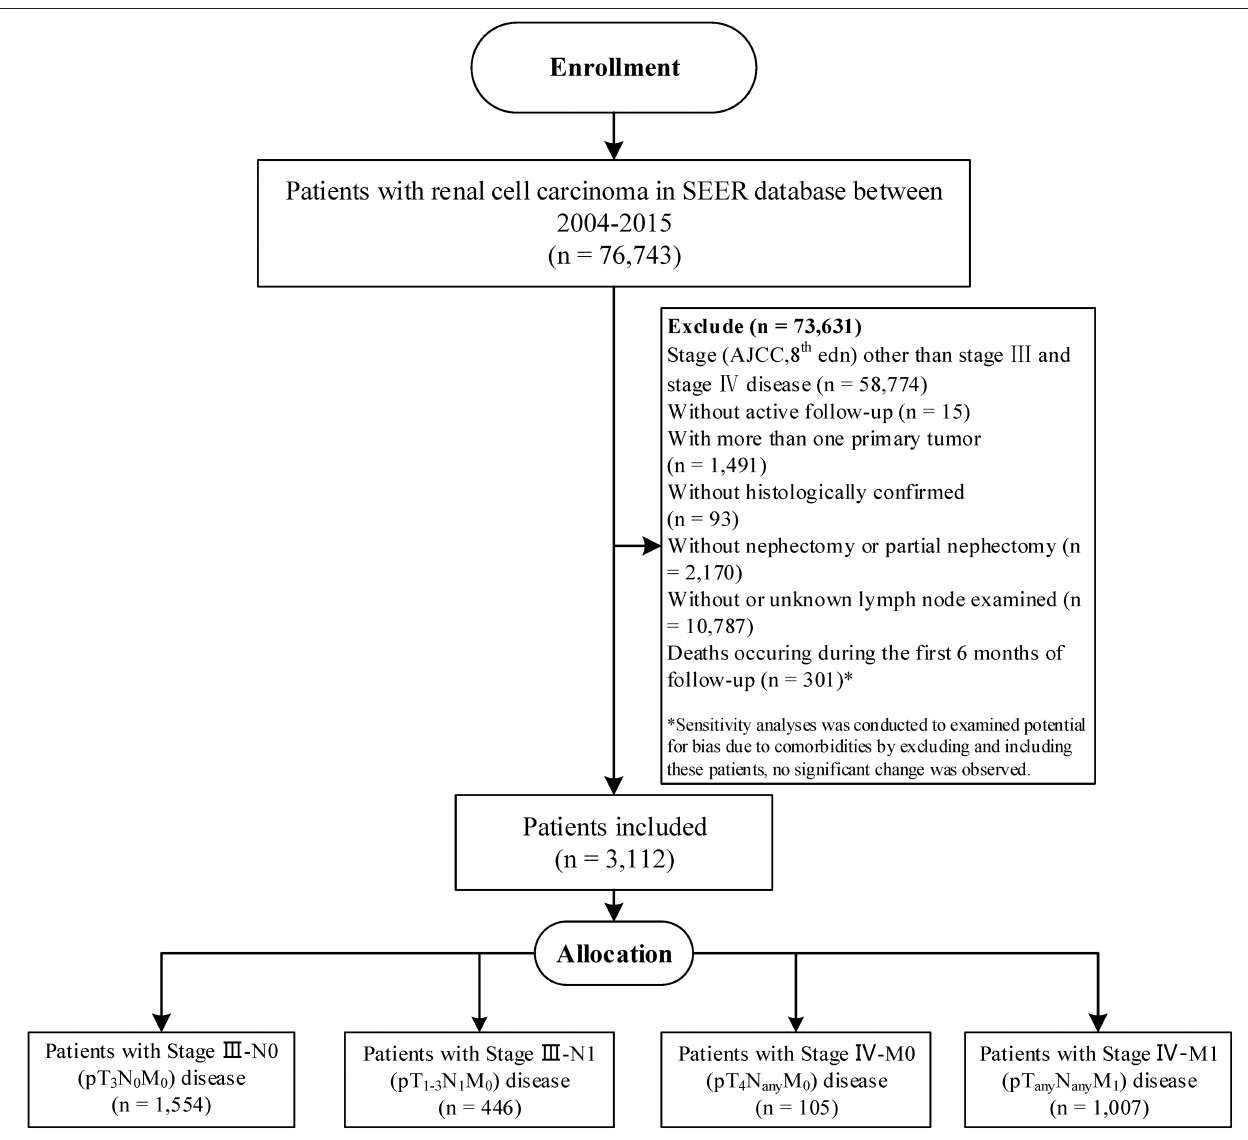
FIGURE 1 | The flowchart of study population